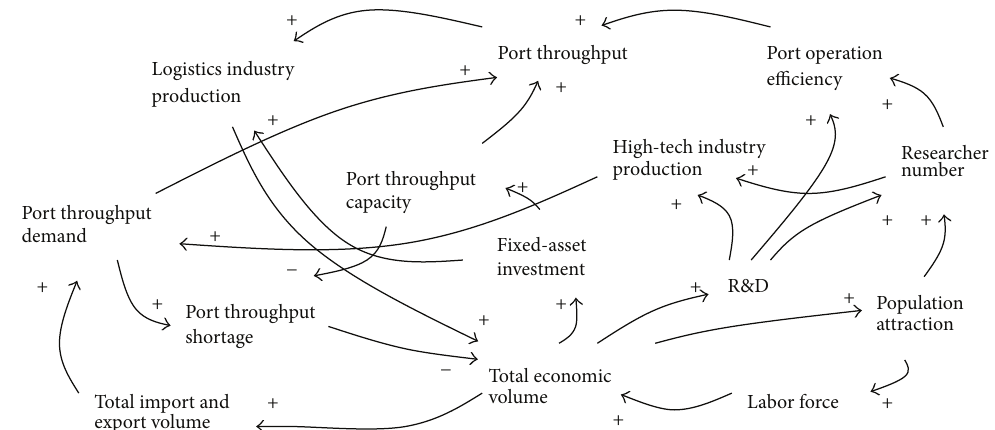
Figure 1: The cause-effect diagram of port-city interaction system.